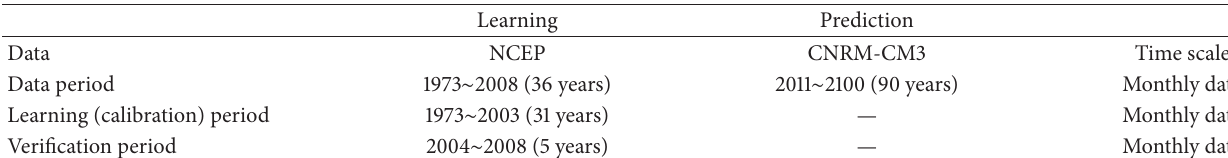
Table 1: Input data of ANN.